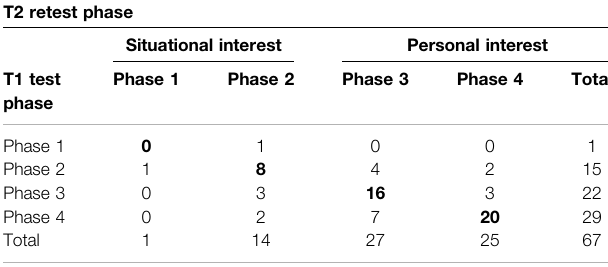
TABLE 4 | Phase of interest for participants at T1 (Test) and T2 (Retest). T2 retest